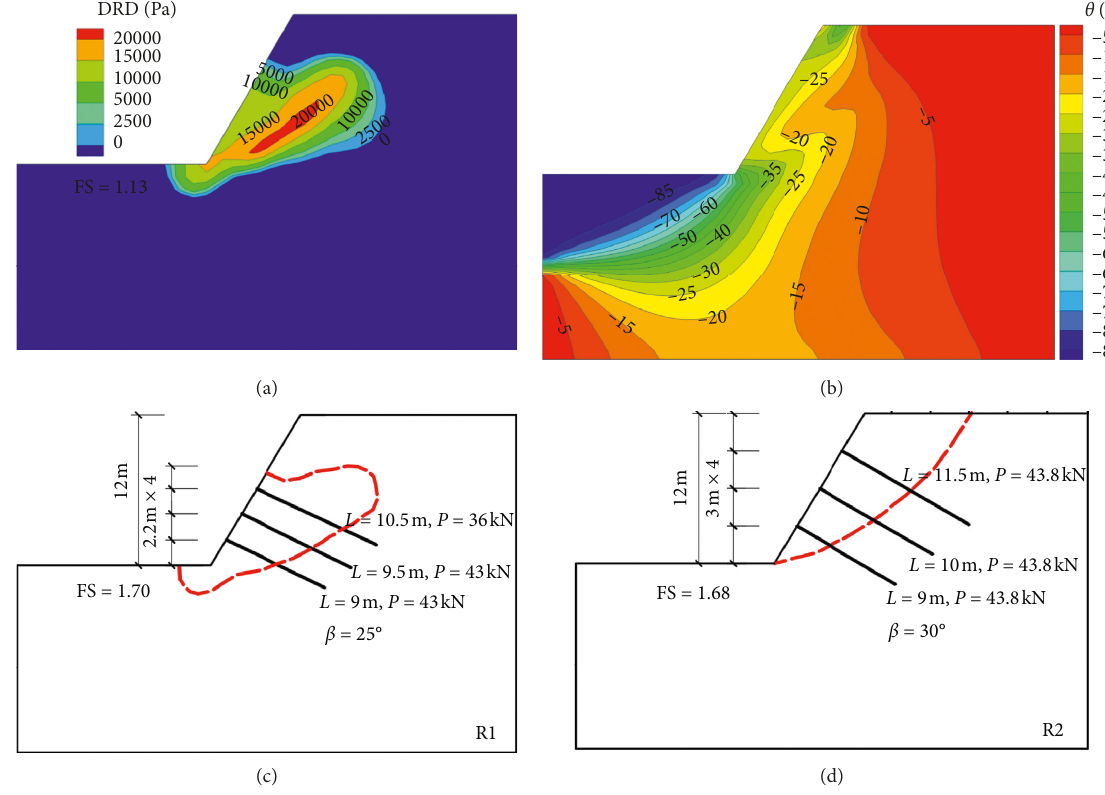
Figure 14: Design and comparison of reinforcement scheme at 60 ° slope. (a) The contour map of DRD for 75 ° slopes, (b) the azimuth of Δ σ for 75 ° slopes, (c) reinforcement design of quantitative reinforcement analysis, and (d) reinforcement design of Bishop’s simplified